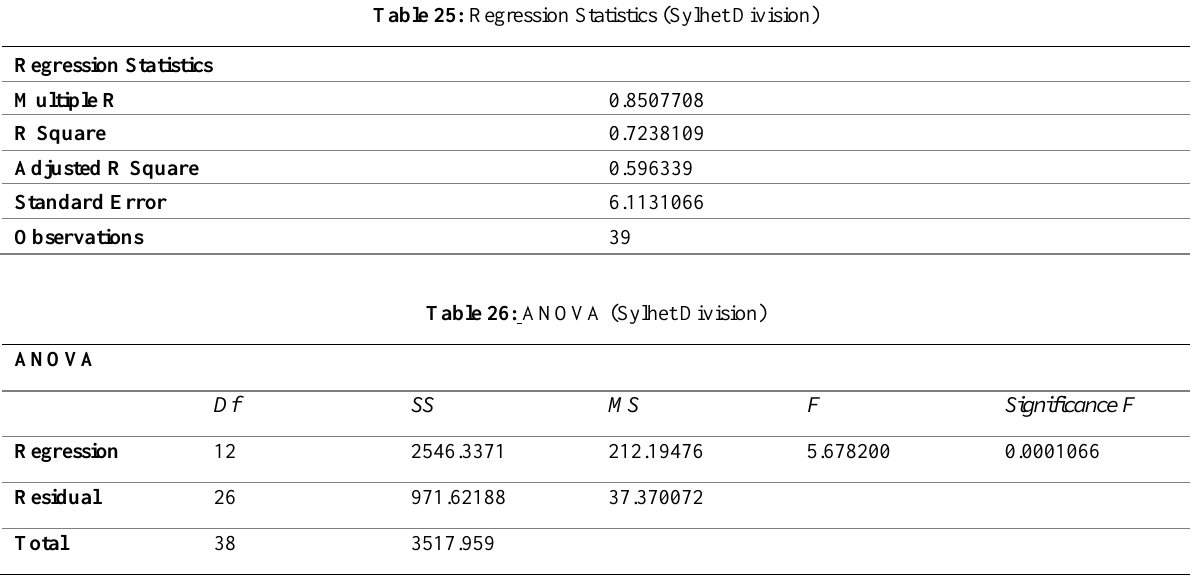
Table 25: Regression Statistics (Sylhet Division)